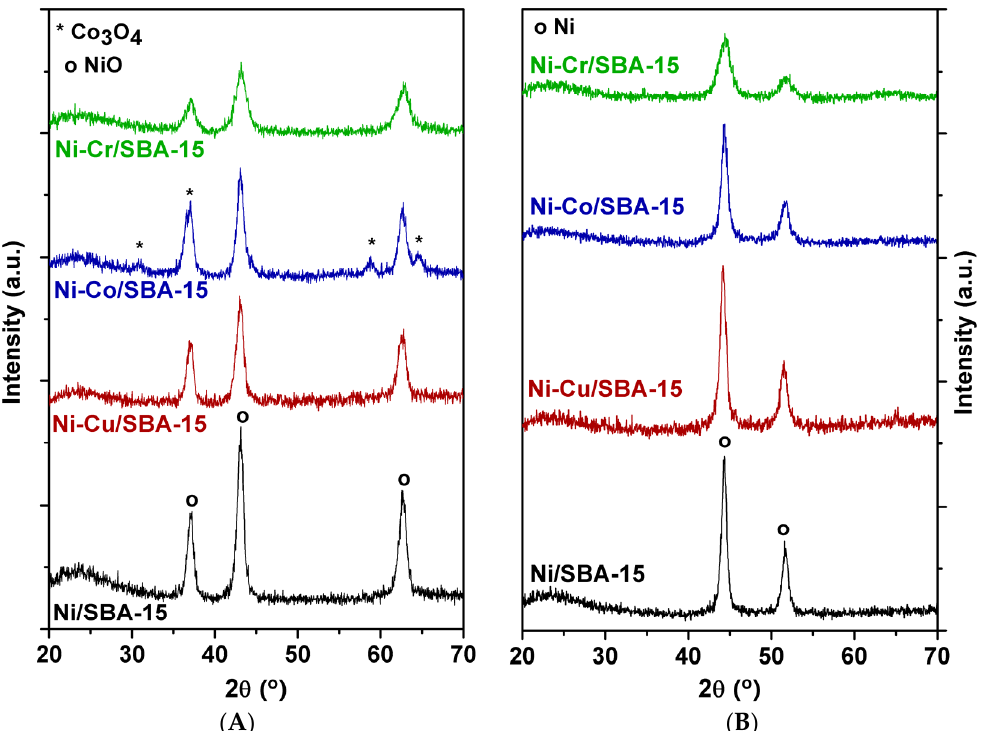
Figure 3. Wide-angle X-ray diffraction of the Ni-(Cu,Co,Cr)/SBA-15 catalysts and the support: ( A ) calcined; and ( B ) reduced.